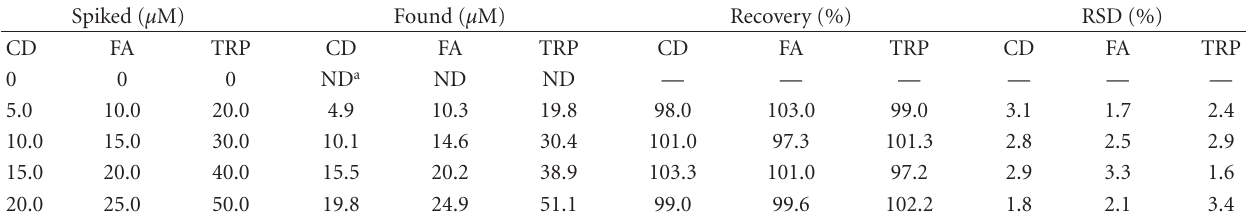
Table 2: Comparison of the e ffi ciency of some modified electrodes used in the electrocatalysis of LD. Electrode Carbon paste Carbon paste Carbon paste Carbon Nanotube paste Table 3: The application of FCDCNPE for simultaneous determination of CD, FA, and TRP in urine. All concentrations are in μ M ( n = 5). Spiked ( μ M)